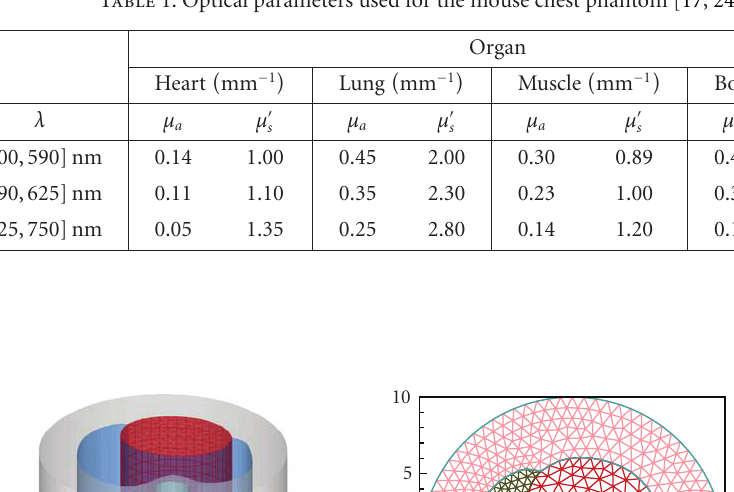
Table 1: Optical parameters used for the mouse chest phantom [17, 24].